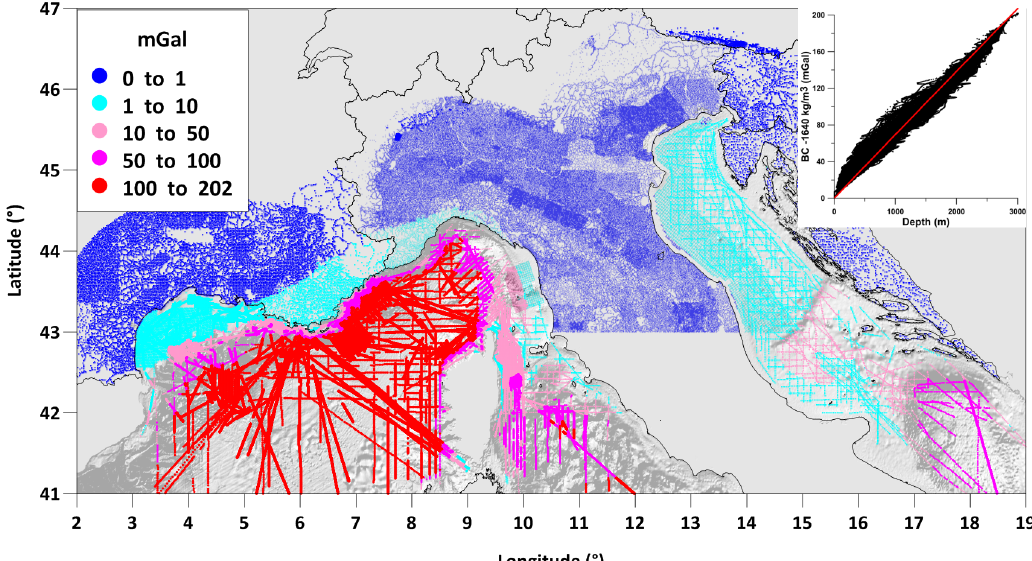
Figure 5. Map of bathymetric corrections (up to the distance of 166.7km, density 1640kgm − 3 ). Only non-zero values are shown on the map within 167km of the sea. Shaded relief in the background shows the bathymetry of the seabed. The graph in the upper right corner shows the depth-dependence of bathymetric corrections. The red line represents their simple “Bouguer plate” approximation for comparison.